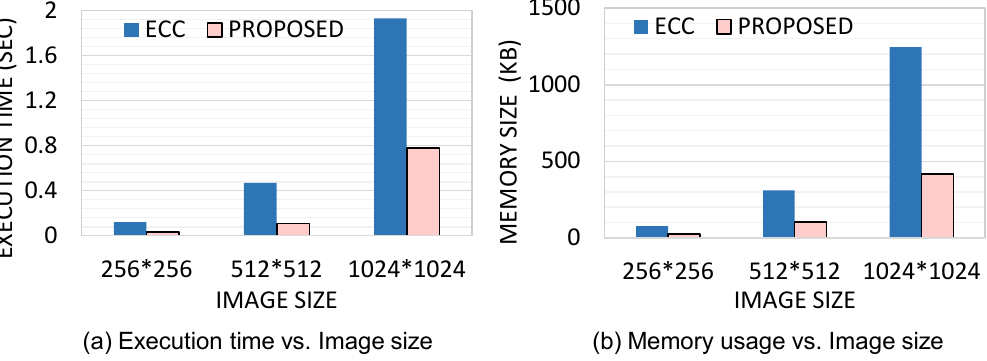
Figure 12. Emulated execution time ( a ) and memory usage ( b ) with proposed method and